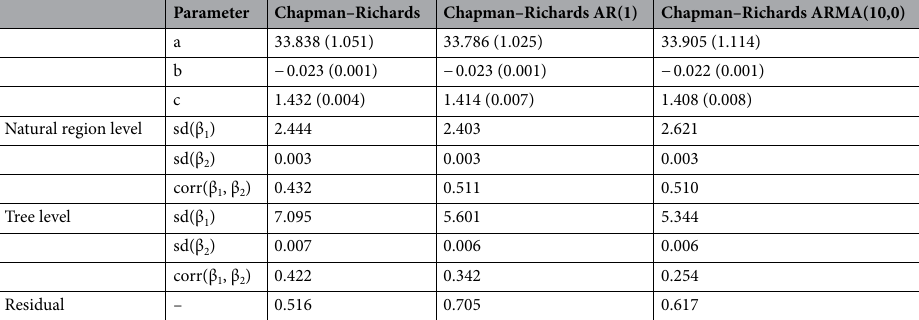
Table 4. The parameter estimates and standard errors (in brackets) of the best fitted mixed-effects Chapman– Richards model with (Chapman-Richards AR(1), AR(10) and without (Chapman-Richards)) autoregressive correlation